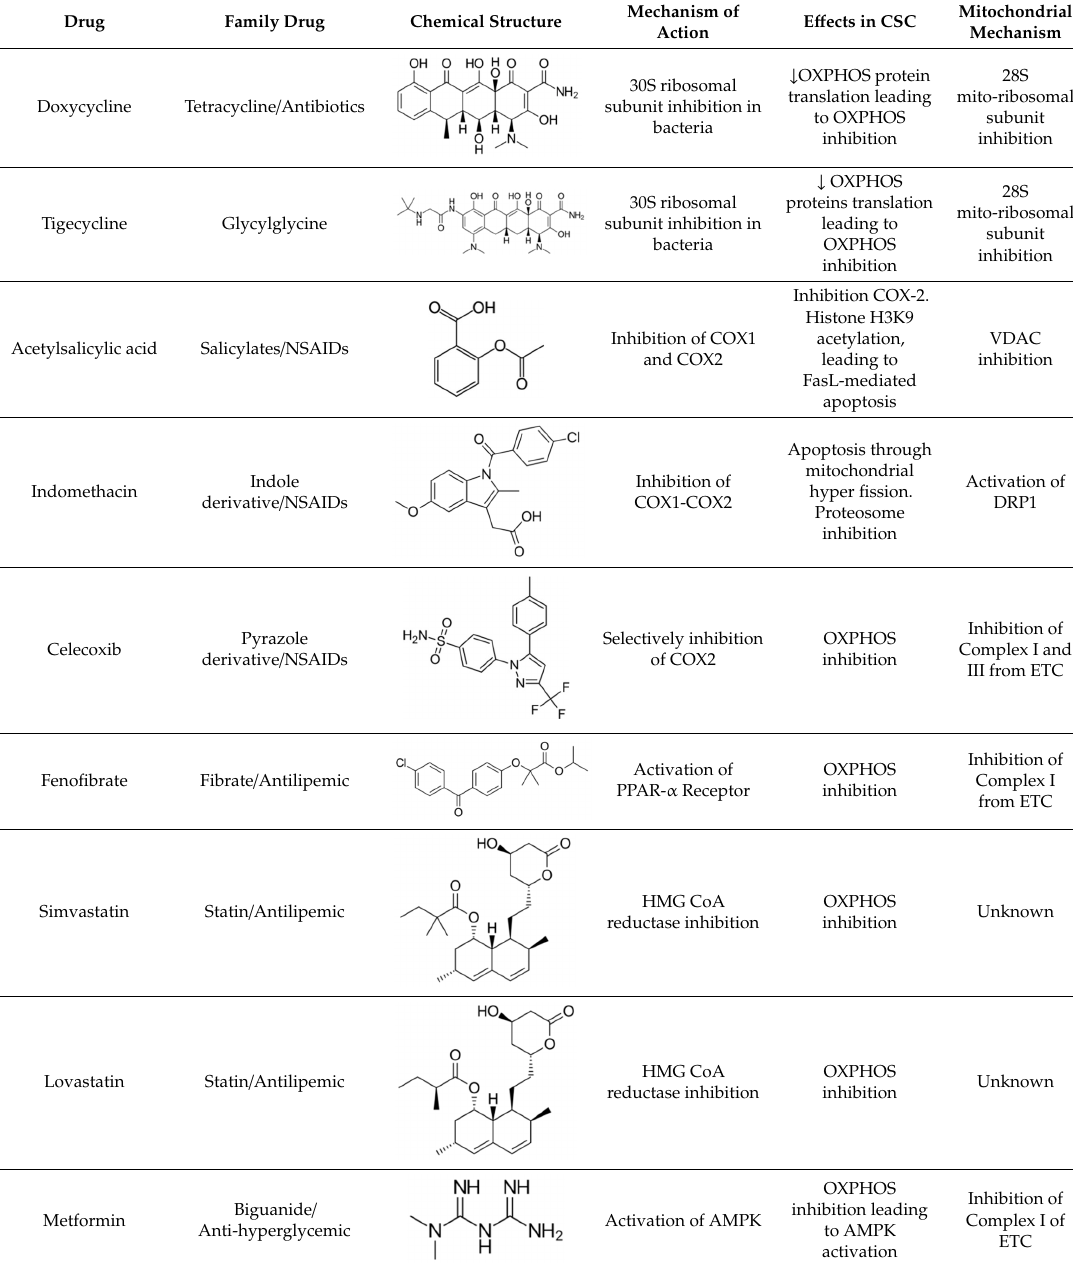
Table 2. Summary of most important old repurposing drugs for cancer stem cells.